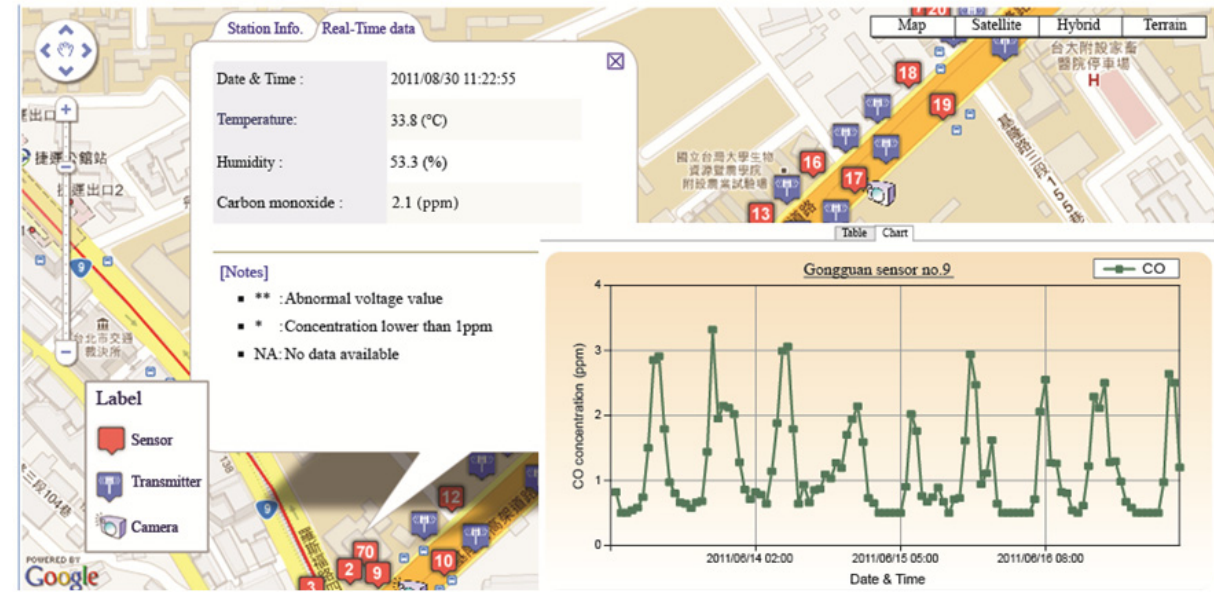
Figure 6. Map-based monitoring and control